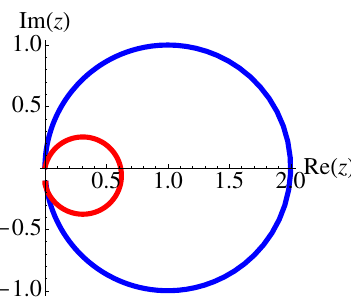
Figure 6 . The path (in blue) followed by z ( t ) as t is dialled from 0 to ( ‘ 1 + ‘ 2 ) = 2 with a quench width (cid:15) = 0 : 005, (cid:12) = 0 : 5, ‘ 1 = 0 : 2 and ‘ 2 = 1 : 8. The continuation of the same for t > ( ‘ 1 + ‘ 2 ) = 2 is performed by introducing an imaginary part for t , so that t ! t + i(cid:15) 1 where (cid:15) 1 (cid:25) 0 : 02. The resulting path is shown in red. Importantly, the latter path does not encircle z = 1, and approaches z = 0 for large t